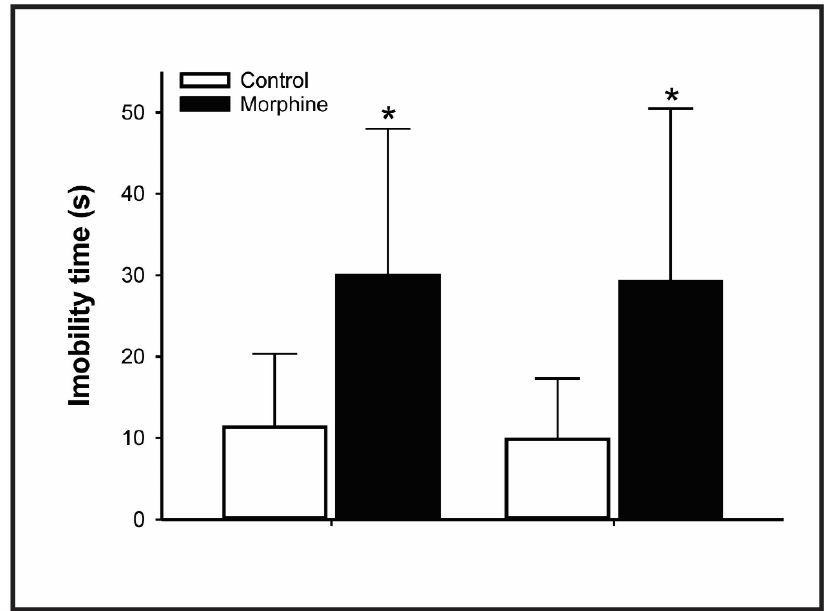
Figure 5. Effect of morphine treatment (10 mg/kg/day) during pregnancy and lactation on rat offspring immobility time in the forced swimming test. Results expressed as mean ± S.D.M. (male control = 10; female control = 10; male morphine = 8; female morphine = 10). * p < 0.05 morphine vs. respective control group. Student’s t ‐ test.